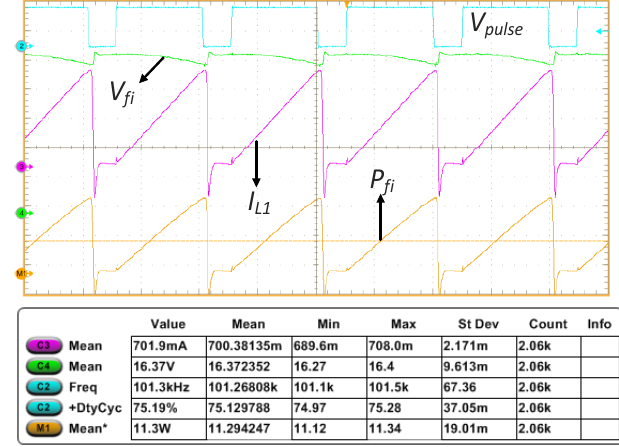
Figure 18. Flyback input power graph. Table 5. Percentage error.